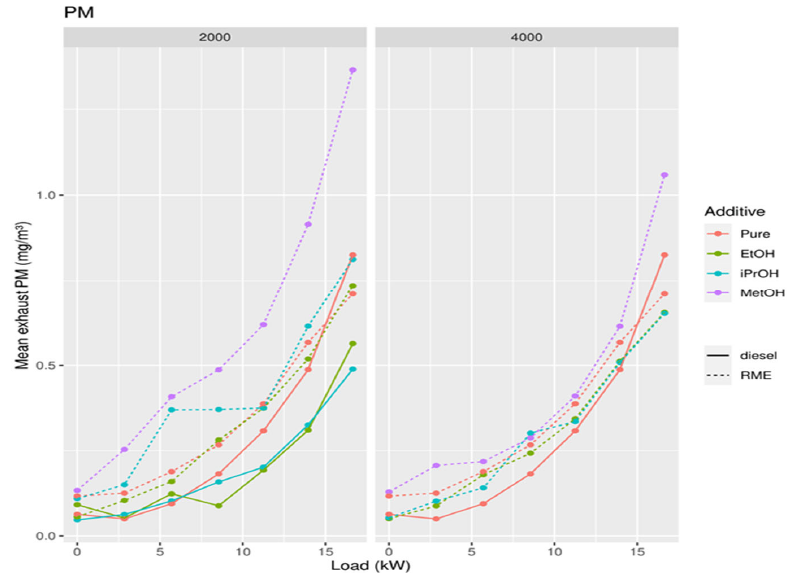
Figure 13. Concentration of PM in exhaust gases in function of the power of the diesel generator after addition of 2000 and 4000 ppm of methanol, ethanol, and isopropanol to biodiesel. Exhaust measurements were carried out in duplicate at 7 different loads (0 kW (idle), 0.65 kW, 1.31 kW, 1.97 kW, 2.59 kW, 3.21 kW, and 3.83 kW) and for different mixtures of RME with alcohol additives. To obtain a summary value, describing the exhaust of a par ‐ ticular condition across the entire range of powers, the exhaust was plotted versus the load for each experiment and the area under the curve (AUC) was calculated. These AUC values for each condition served as input for the subsequent statistical analyses. A higher